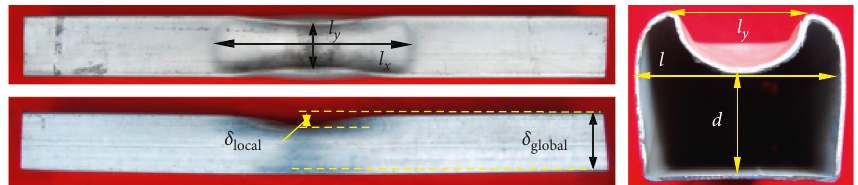
Figure 3: Description of the parameters of the deformation.